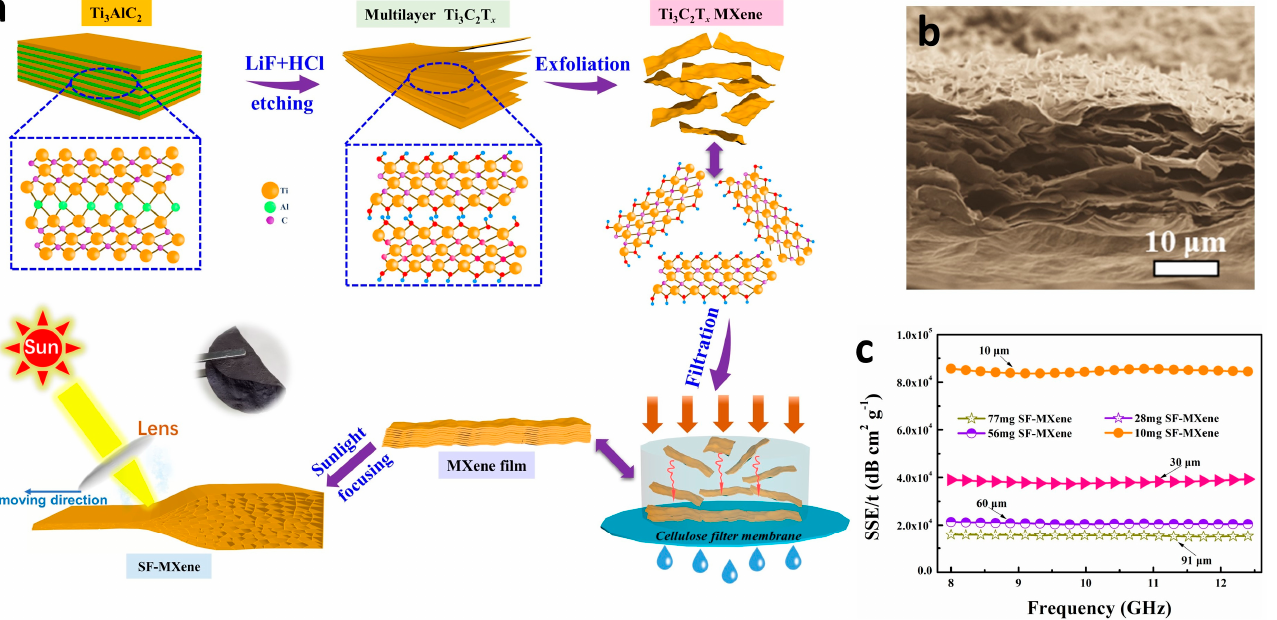
Figure 16. ( a ) Schematic diagram of 3D porous MXene film (SF-MXene) synthesis using focused sunlight. ( b ) Cross-sectional SEM image of SF-MXene. ( c ) SSE/ t values of SF-MXene with different thicknesses; reproduced from [62], with the permission of Elsevier.